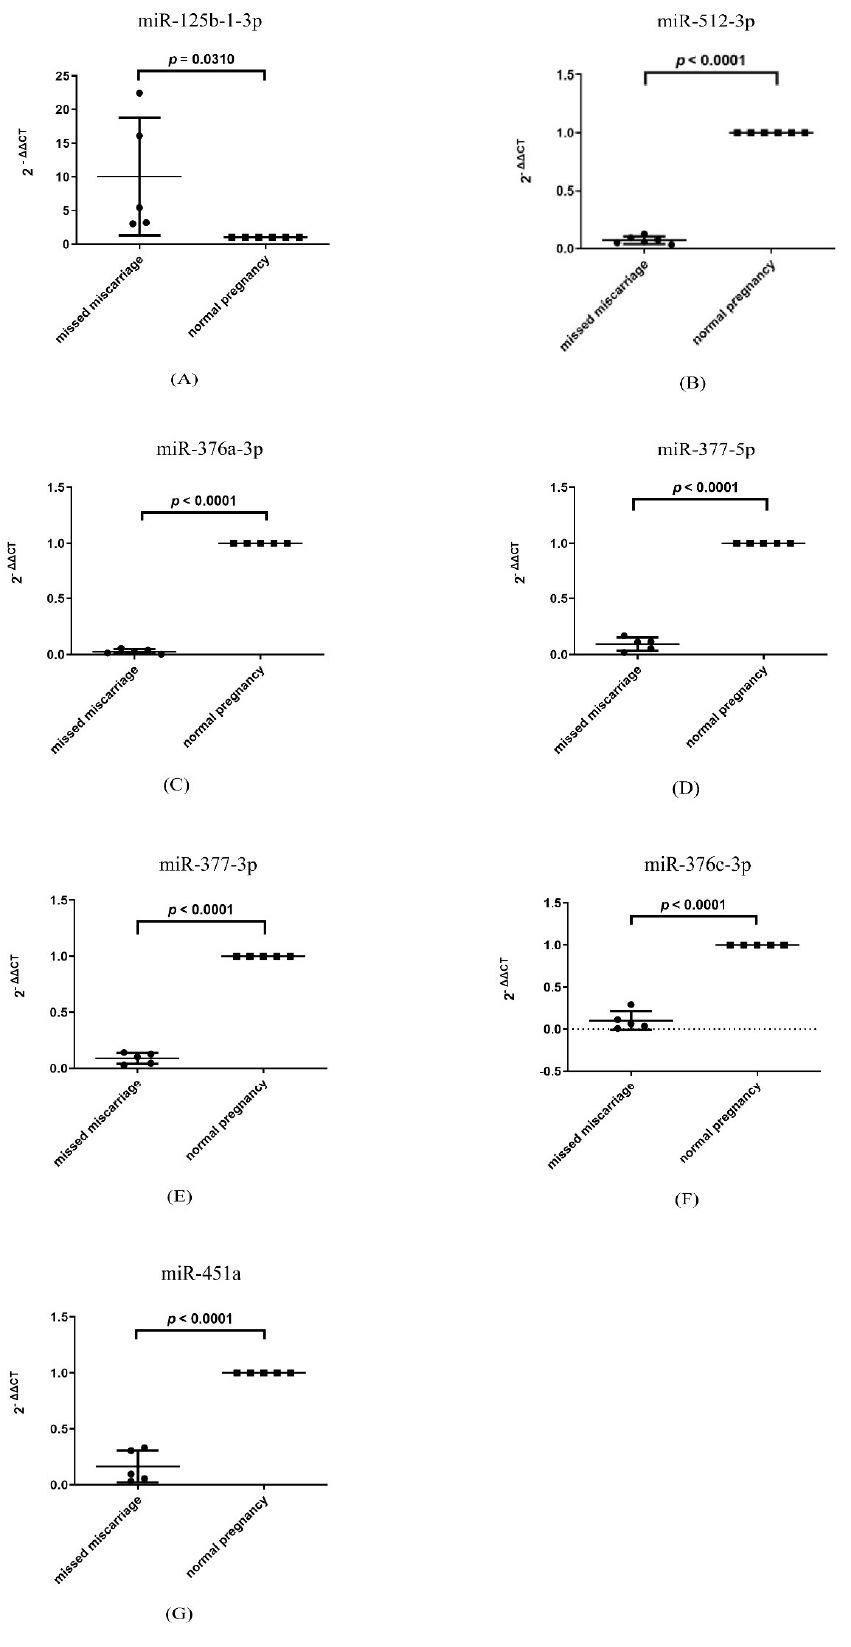
Figure 4. ( A – G ): The levels of senescence-associated miRNAs in missed miscarriage placentae (data represents mean ± SD with five